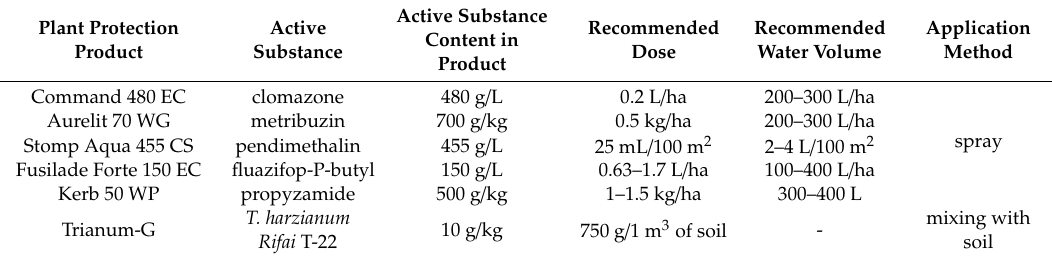
Table 4. Recommended application, based on the labels